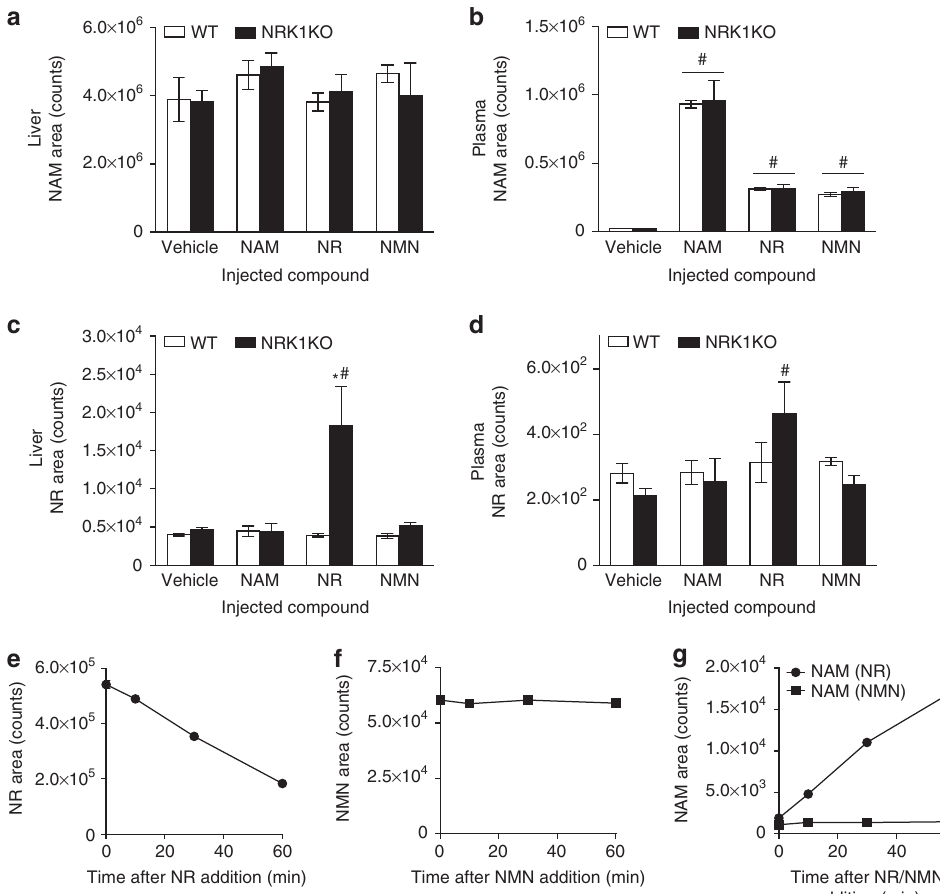
Figure 8 | Intraperitoneal injected NR and NMN partially degrades to NAM. ( a – d ) Five to six weeks old WTand NRK1KO male mice were IP injected with 50mgkg (cid:2) 1 of indicated compound and blood liver samples were collected after 1h, n ¼ 4 per group. Then, NAM level in liver ( a ) and plasma ( b ) were measured, as well as NR level in liver ( c ) and plasma ( d ) of these animals. ( e – g ) NR and NMN stability in isolated murine plasma. Plasma samples were isolated from NRK1KO mice. 0.5mM NR or NMN was incubated with plasma at 37 (cid:2) C for 60min. NR ( e ), NMN ( f ) and NAM ( g ) level was measured in samples by LC-QqQ MS. Results shown are mean ± s.e.m., * P o 0.05 versus WT; # P o 0.05 versus vehicle by one-way ANOVA followed by Bonferroni’s post-hoc test ( n ¼